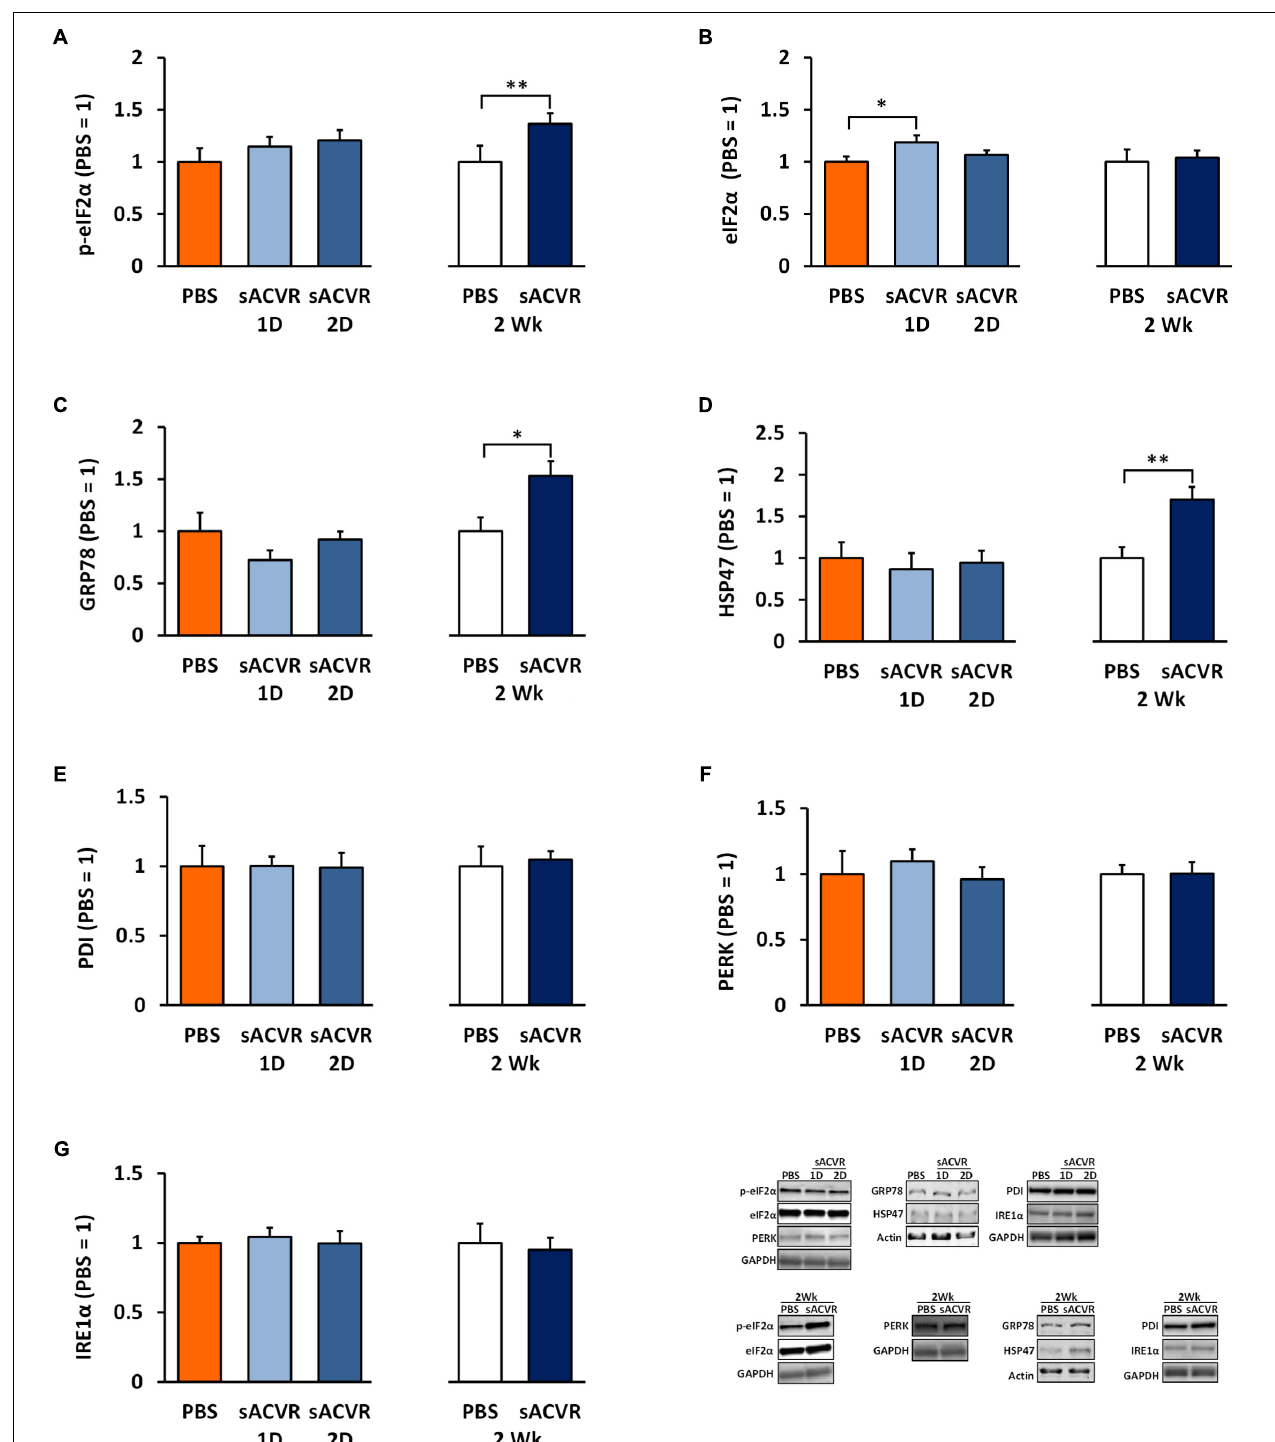
FIGURE 2 | Unfolded protein response (UPR) markers in healthy skeletal muscle in mice that were administered with soluble activin receptor type 2B (sACVR) or vehicle (PBS). Muscles were collected 1 or 2 days after a single sACVR administration or after 2 weeks of administration. (A) p-eIF2 α ser51 , (B) total eIF2 α protein, (C) GRP78 protein, (D) HSP47 protein, (E) PDI protein, (F) PERK protein, (G) IRE1 α protein; n = 6–7 in all groups except n = 9–11 in sACVR 2 Wk group. The symbol ∗ depicts statistical significance p < 0.05 whereas the symbol ∗∗ depicts statistical significance p < 0.01. Data is expressed as means ± SE. Representative blots were cropped from the original blot images ( Supplementary Figures 6–8 ). Representative blots with same IDs and analyzed in the same run are aligned on top of each other and share the same representative control blot (GAPDH or actin).